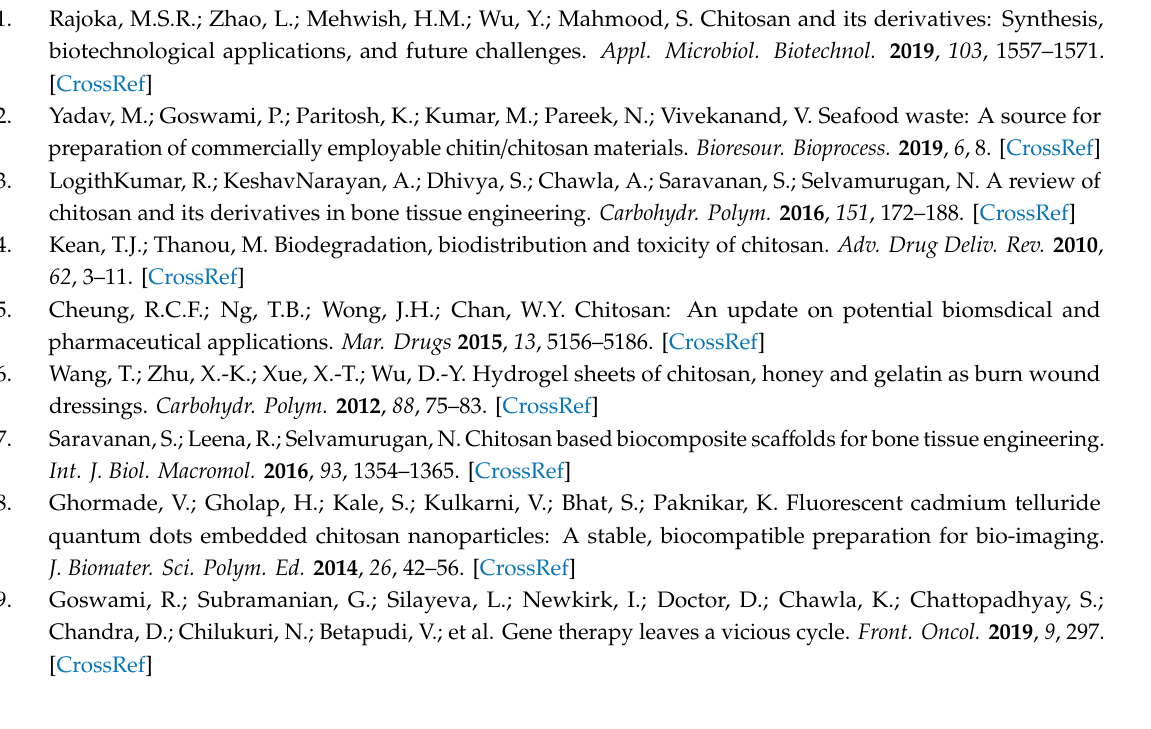
E ff ect of temperature on microwave-assisted depolymerization of CS-A; Table S3: E ff ect of concentration on microwave-assisted depolymerization of CS-A, Table S4: Conditions tested for microwave-assisted depolymerization of CS-B, Table S5: Error range of GPC values, Figure S1: Error range of GPC values, Figure S2: Decrease in molecular weight and PD dependence on pH, Figure S3: Solubility of CS-A, CS-B and dCS-A in